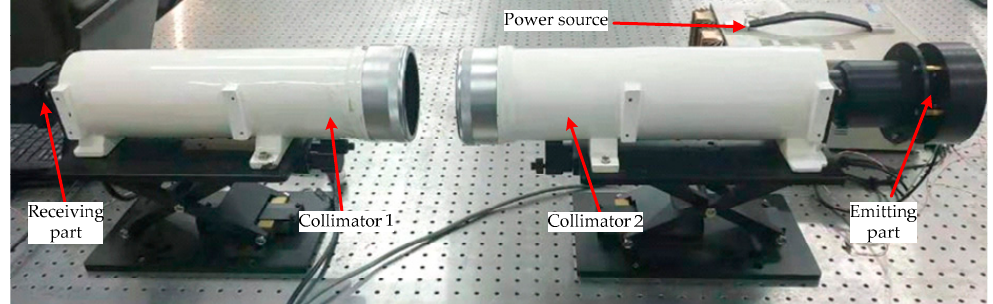
Figure 5. Layout of experimental setup.